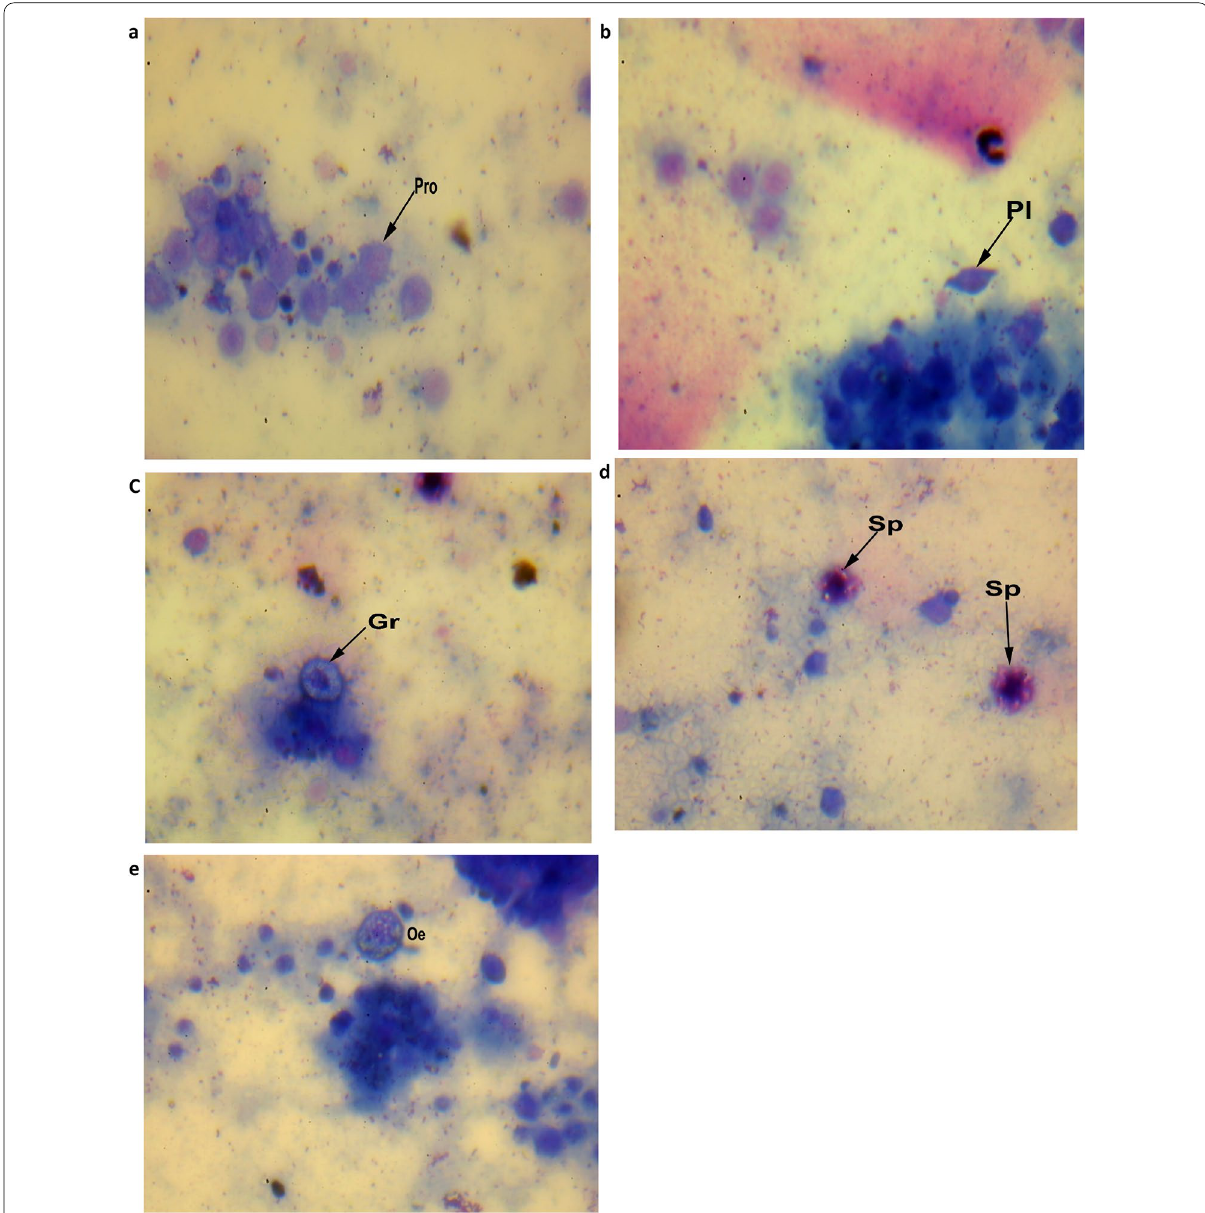
Fig. 1 Light microscopic graph of hemocytes obtained from the whole hemolymph of untreated sixth instar larvae of Spodoptera littoralis stained with Giemsa staining: a : Prohemocytes (Pro), b Plasmohemocytes (Pl), c Granulocytes (Gr), d Spherocytes (Sp), and e Oenocytoid (Oe) (